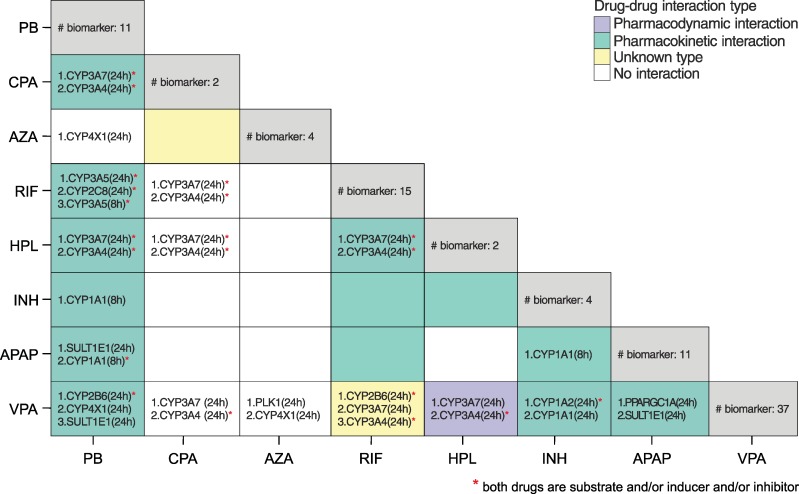
Potential DDIs between the high-responsive drugs.The total number of identified biomarkers for each drug is shown on the diagonal. The biomarkers were ranked according to the absolute differences of toxic change between both considered drugs. Measures of the performance were additionally calculated by comparing predicted DDIs with known DDIs from literature: accuracy = 68%, sensitivity = 75%, specificity = 58%, and precision = 71%.